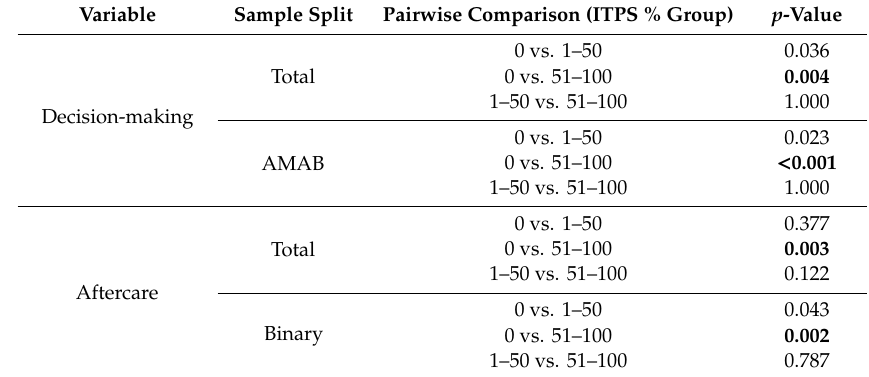
Table 2. Post-hoc analysis pairwise comparisons for significant results of Kruskal–Wallis H tests. Variable Sample Split Pairwise Comparison (ITPS % Group)